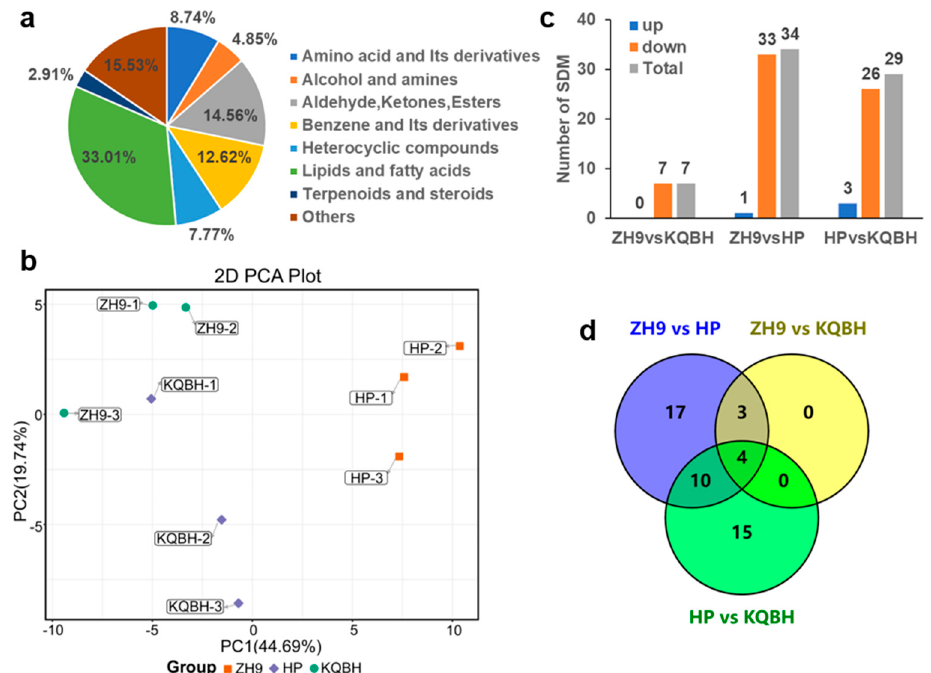
Figure 2. Identification of differential metabolites in the peanut seeds through MALDI-MSI. ( a ) The classification of 103 metabolites detected by MALDI-MSI, ( b ) principal component analysis (PCA) of MALDI-TOF MS mass spectra of the three peanut cultivars (three biological replicates), ( c ) summary of significant differential metabolites (SDMs) between different comparison sets, and ( d ) Venn diagram of SDMs among comparison sets.